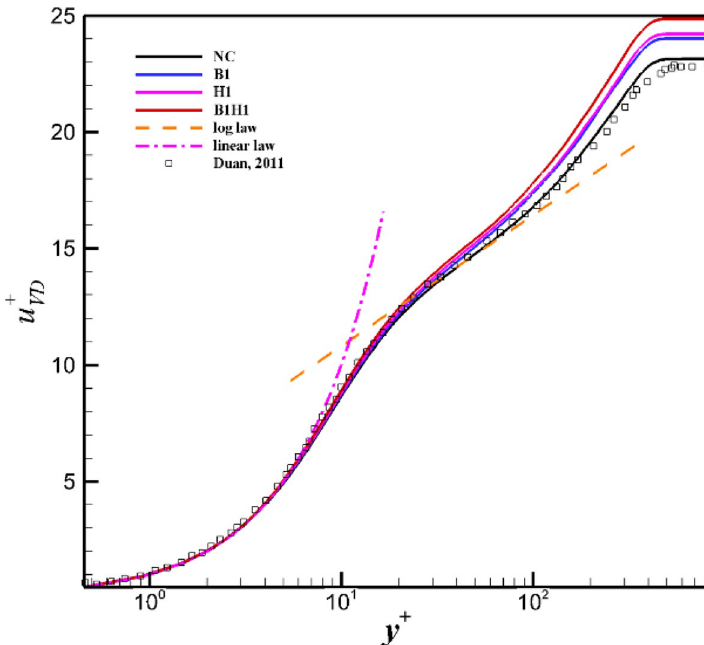
Fig. 9 Profile of van Driest transformed mean velocity obtained at x